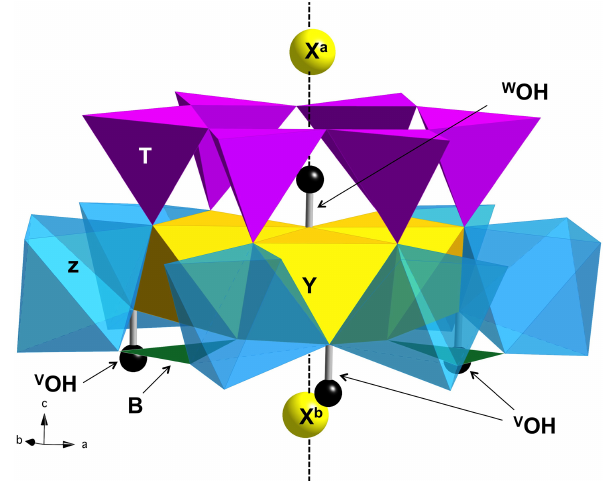
Figure 1. View of the ideal tourmaline structure displaying the main crystal sites involved in a structural YZZ–YZZ–YZZ cluster. The ver- tical dashed line corresponds to the 3-fold axis parallel to the [001] direction of the hexagonal supercell. Three equivalent Y sites and six equivalent Z sites occur in the cluster. The X a and X b sites are equivalent by translational symmetry but occur at different distances from the W OH belonging to a given